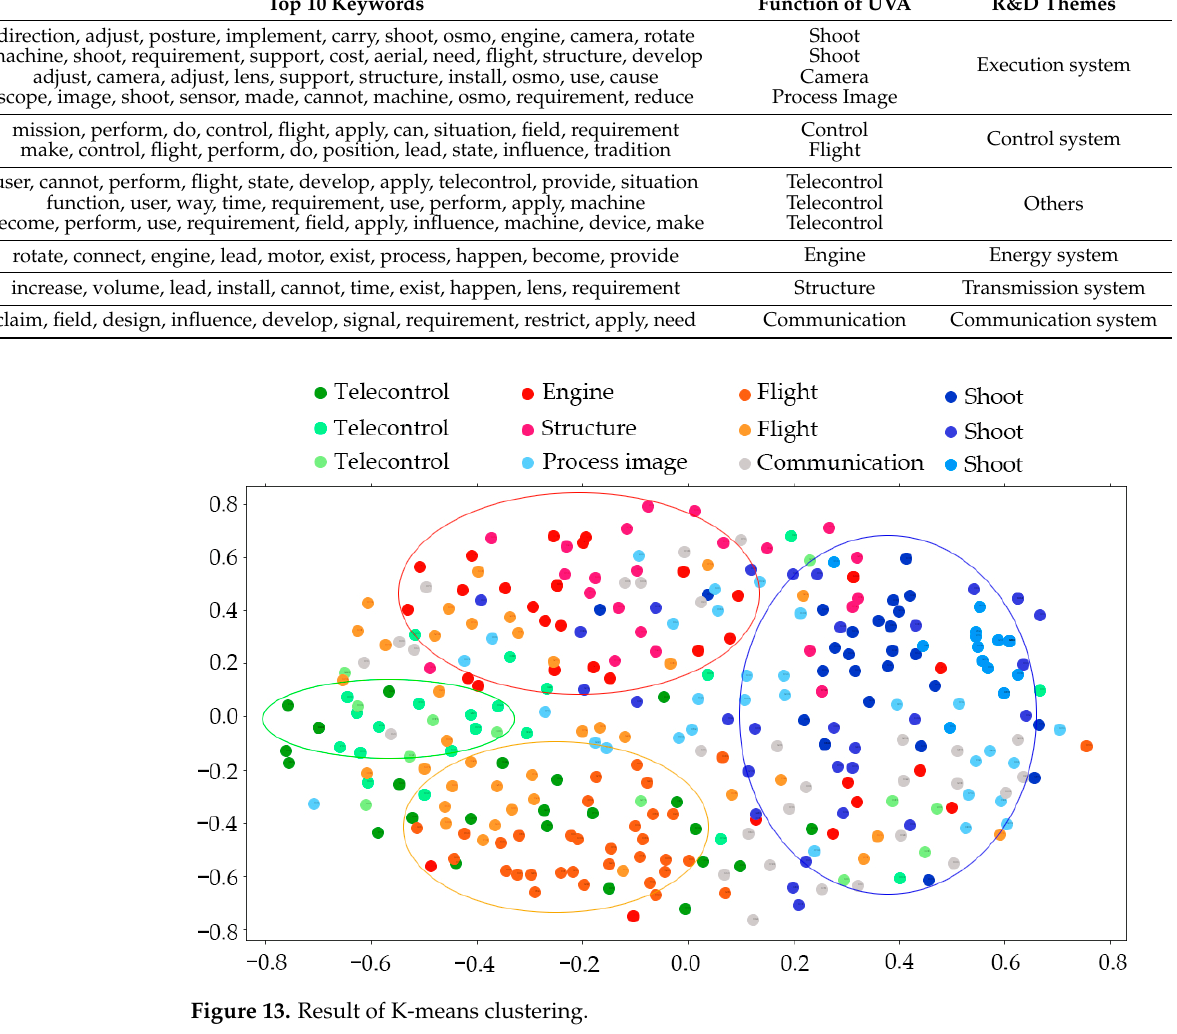
Figure 12. The perplexity for each number of clusters. Table 3. Top 10 keywords of the 12 clusters, and the possibility distribution of six R&D themes. Table 3 lists the final 12 classifications with 10 keywords (the closest to each center). Function of UVA